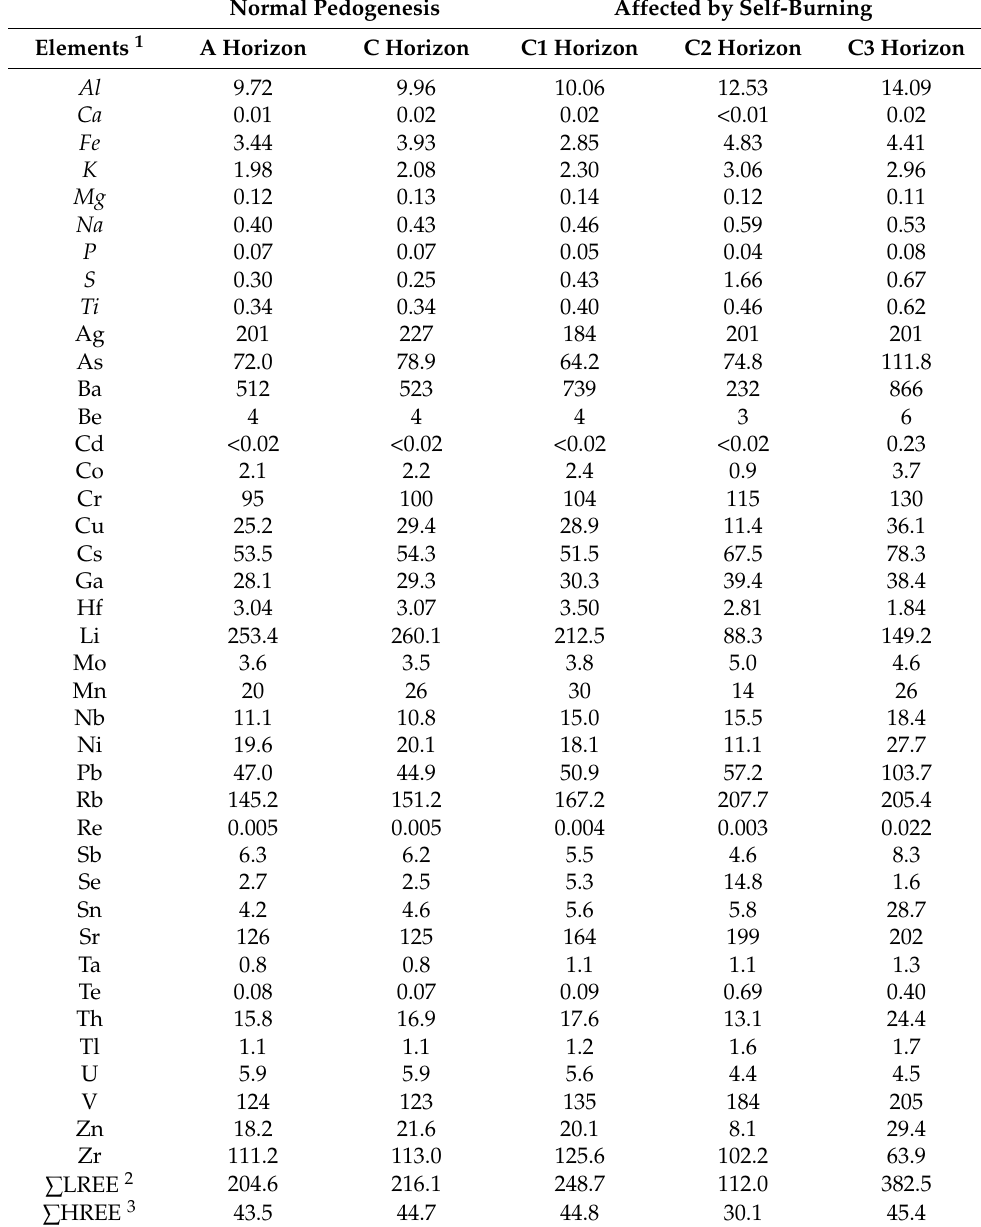
Table 3. Concentrations of major (wt.%) and trace elements (mg/kg) in soil horizons from S ã o Pedro da Cova mine waste